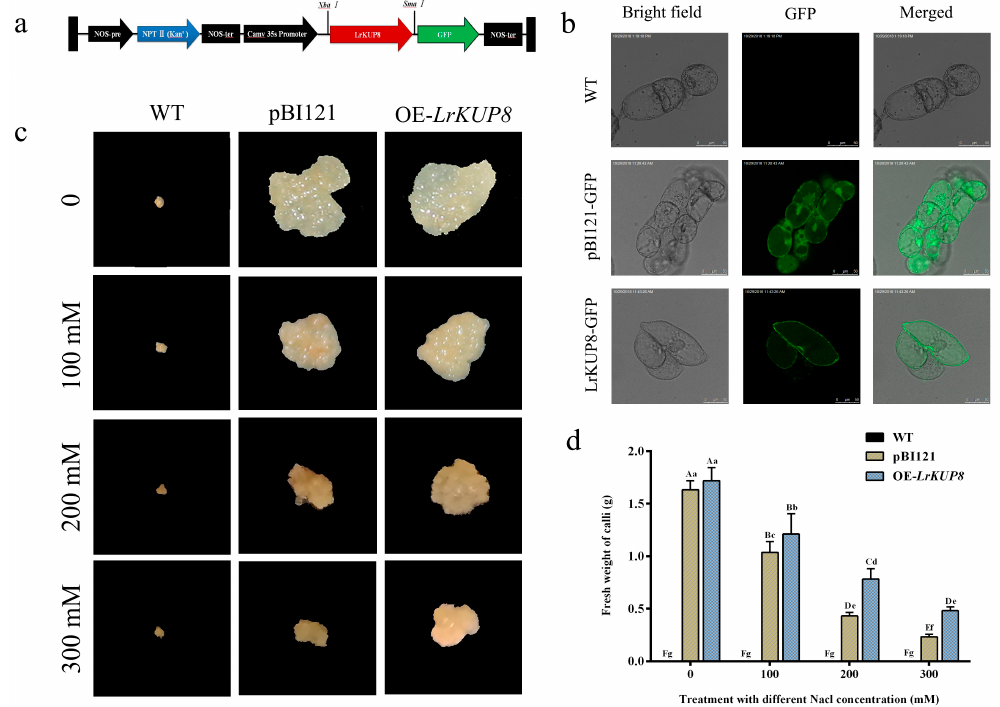
Figure 4. Overexpression of LrKUP8 confers salt tolerance in transgenic calli. ( a ) Schematic representation of the T-DNA region of pBI121. The red and green boxes indicate LrKUP8 and GFP , respectively. ( b ) GFP detection of vector control and LrKUP8 overexpressing calli. ( c ) Phenotype test of vector control and OE- LrKUP8 lines after being grown on medium containing di ff erent Na + concentrations and 50 mM kanamycin for 50 days. ( d ) Fresh weight analysis of vector control and OE- LrKUP8 lines after being grown on medium containing di ff erent Na + concentrations for 50 days. The data in ( d ) are shown as means ± SE ( n = 3). The upper- and lowercase letters on the histogram indicate p < 0.01 and p < 0.05,